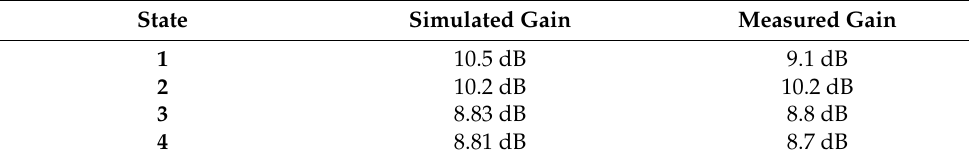
Figure 13. Radiation efficiency values. Table 3. Gain values for different states.